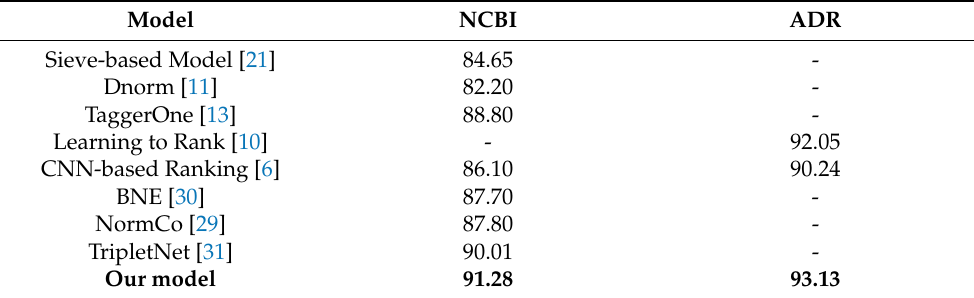
Table 4. Comparison with non-BERT methods. The best performance on each dataset is marked in bold and “-” denotes the result not